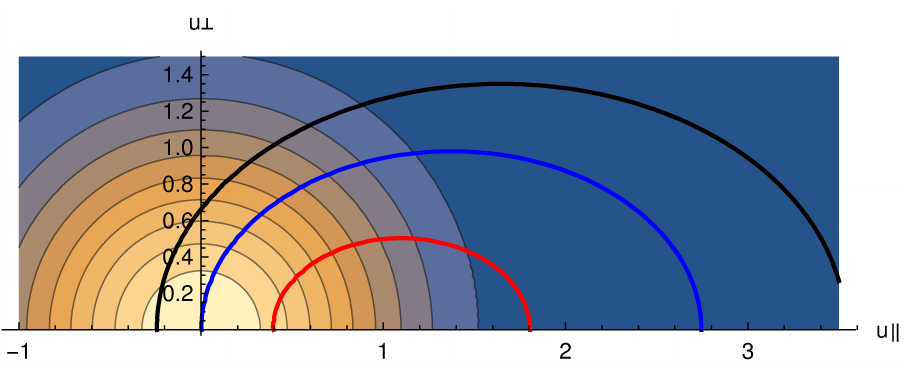
Figure 1. Relativistic resonance curves for N k = 0 . 7 and di ff erent values of Ω (red: Ω = 0 . 8; blue: Ω = 1; black: Ω = 1 . 2). Maxwellian isocontours centred at ( u k , u ⊥ ) = (0 , 0) are also